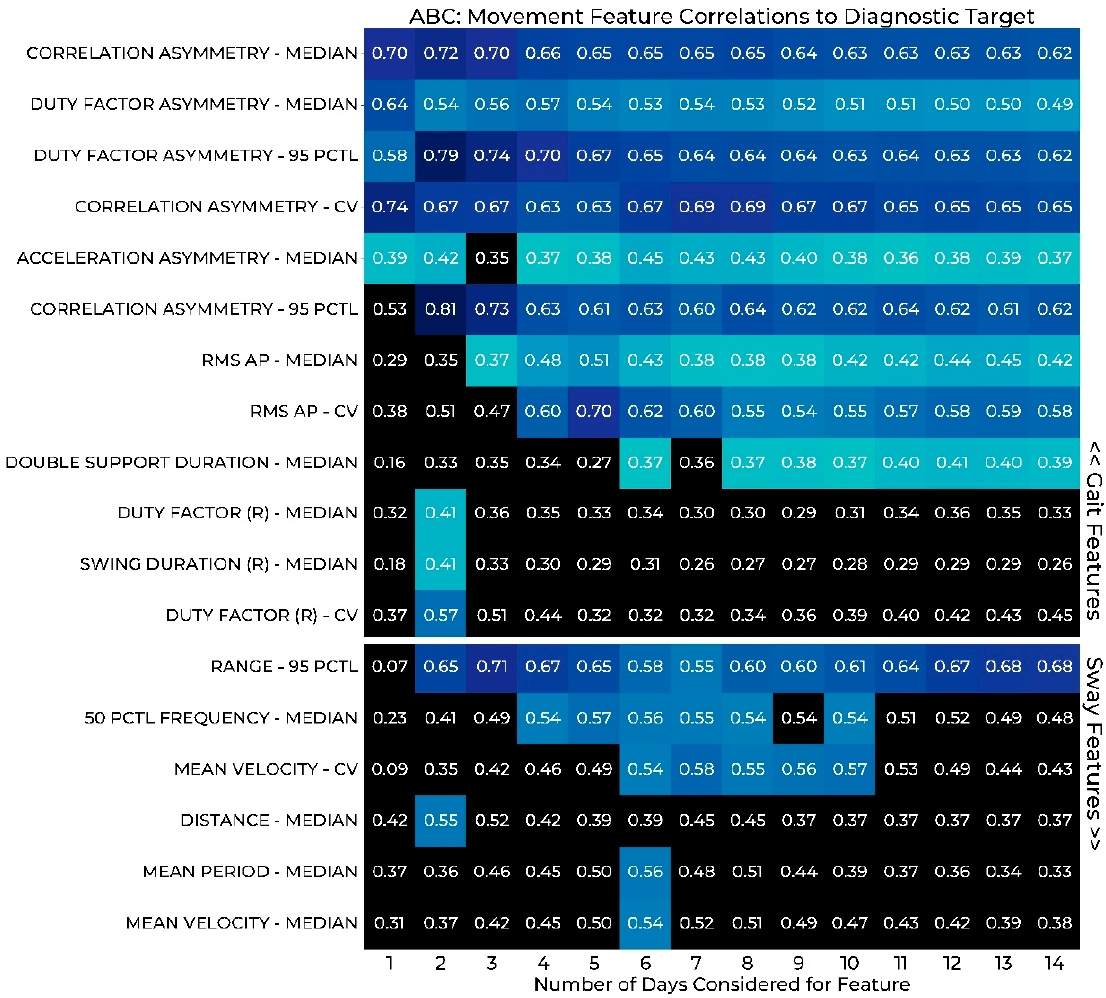
Figure 2. Spearman correlation between Activity-Specific Balance Confidence (ABC) and measures of gait and postural sway by number of sensor-wear days. Cells shaded in blue represent significant correlations (more green = weaker, more blue = stronger) and cells shaded in black were not significant. PCTL: Percentile; CV: Coefficient of Variation; RMS: Root Mean Square; AP: Anterior-Posterior; ML: Medial-Lateral.